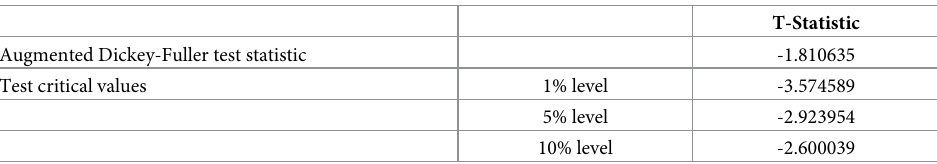
Table 3. Original sequence of ADF test